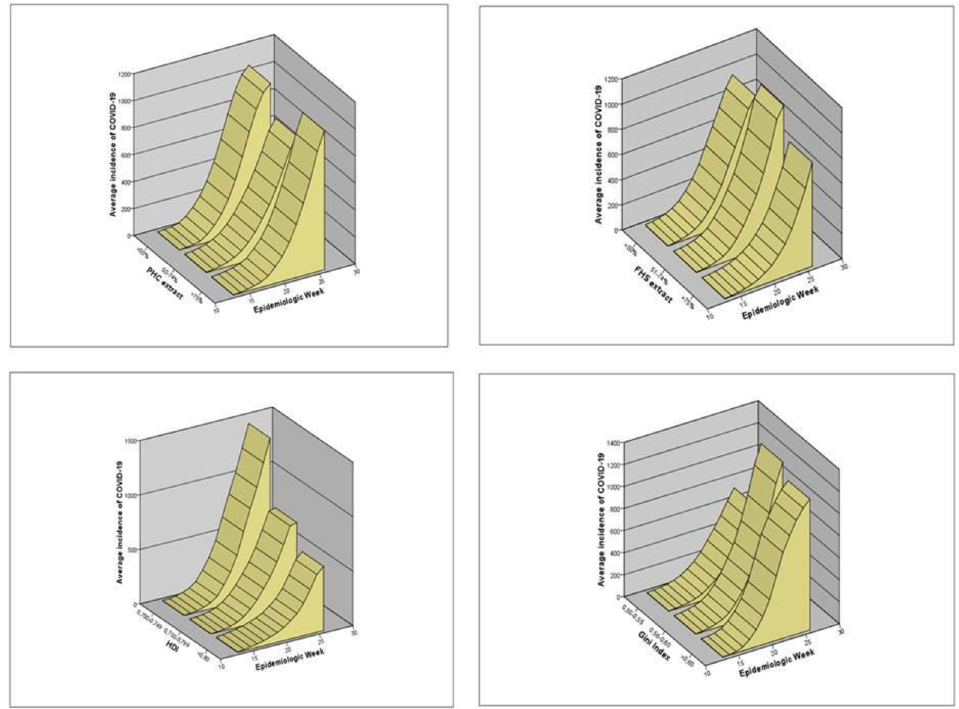
Fig 2. Evolution of the incidence of COVID-19 cases per 100 thousand inhabitants in Brazilian cities until the 26th epidemiological week. A-Stratified incidence by the coverage of Primary Health Care (PHC); B-Incidence stratified by the coverage of FHS; C-Stratified incidence by the HDI; D-Stratified incidence by the Gini Index.